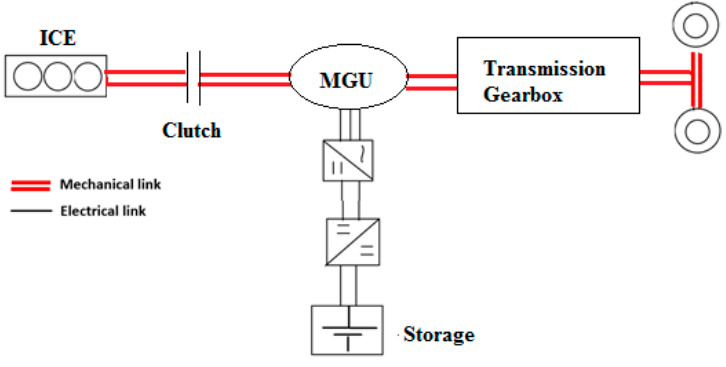
Figure 1. Hybrid parallel powertrain.